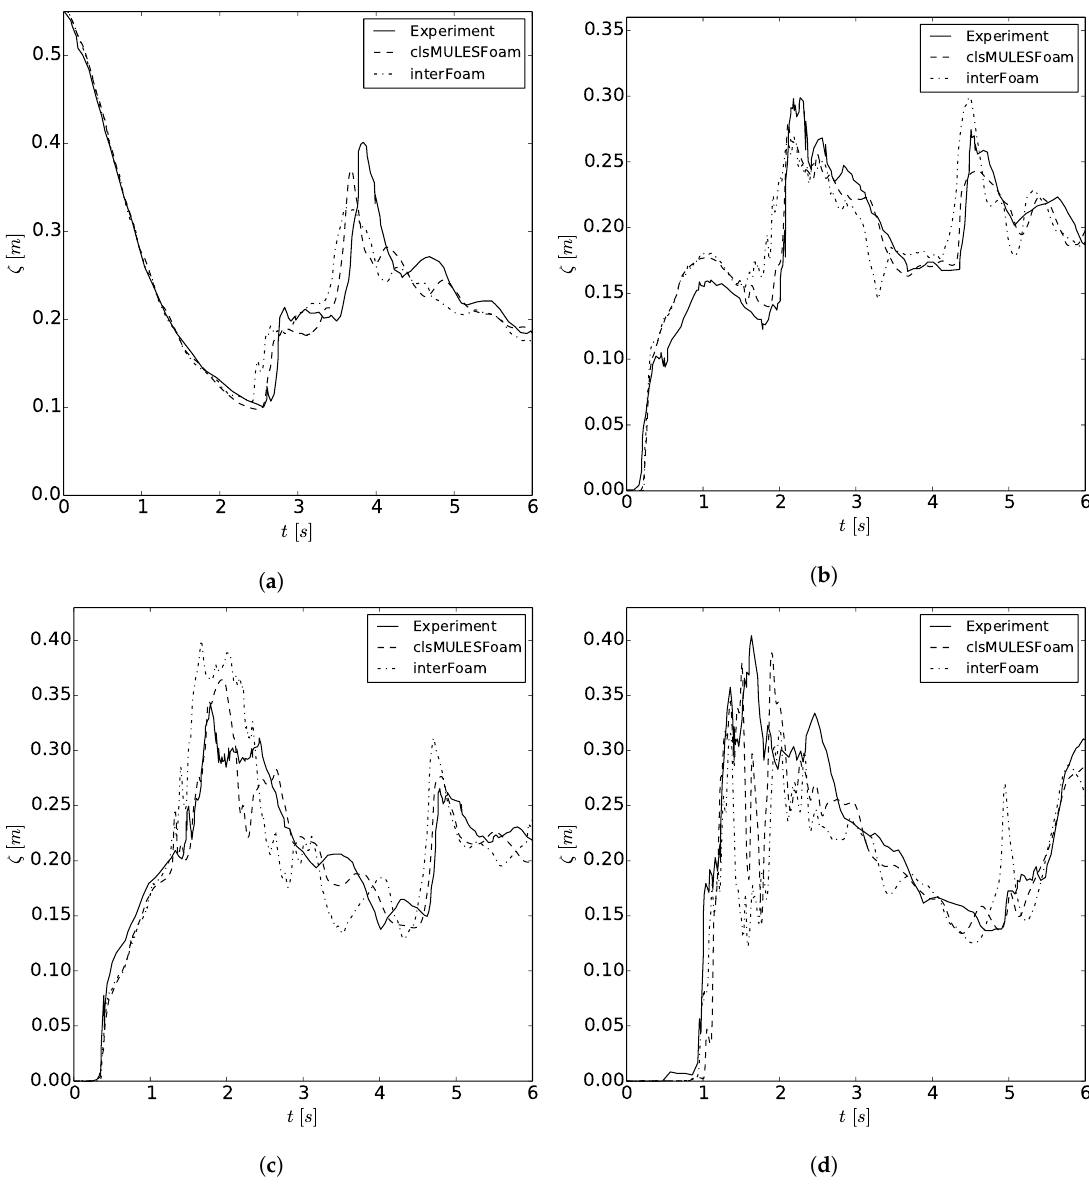
Figure 23. Measured water column heights over time. ( a ) H 1 over time; ( b ) H 2 over time; ( c ) H 3 over time; ( d ) H 4 over